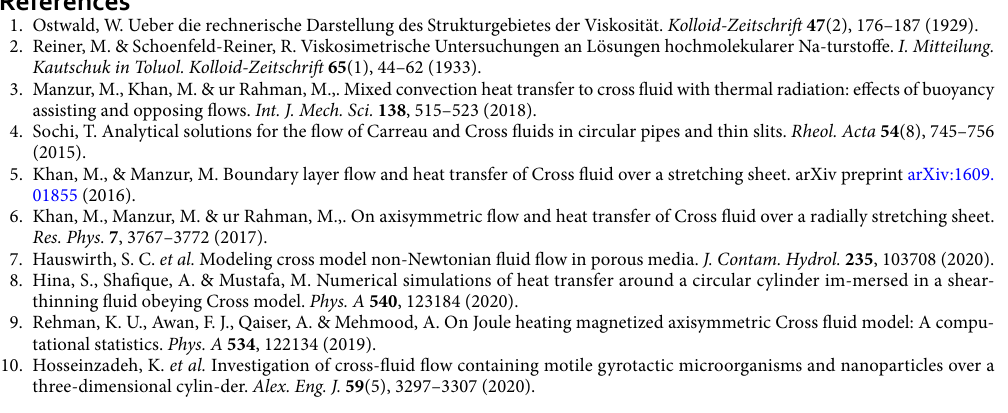
Figure 7. Influences of velocity ratio (cid:31) , mixed convection (cid:31) 1 , heat generation Q , Dufour number D u , radiation Rd , Schmidt number Sc and chemical reaction Ŵ on drag force f ′′ ( 0 ) , heat transfer φ ′ ( 0 ) −